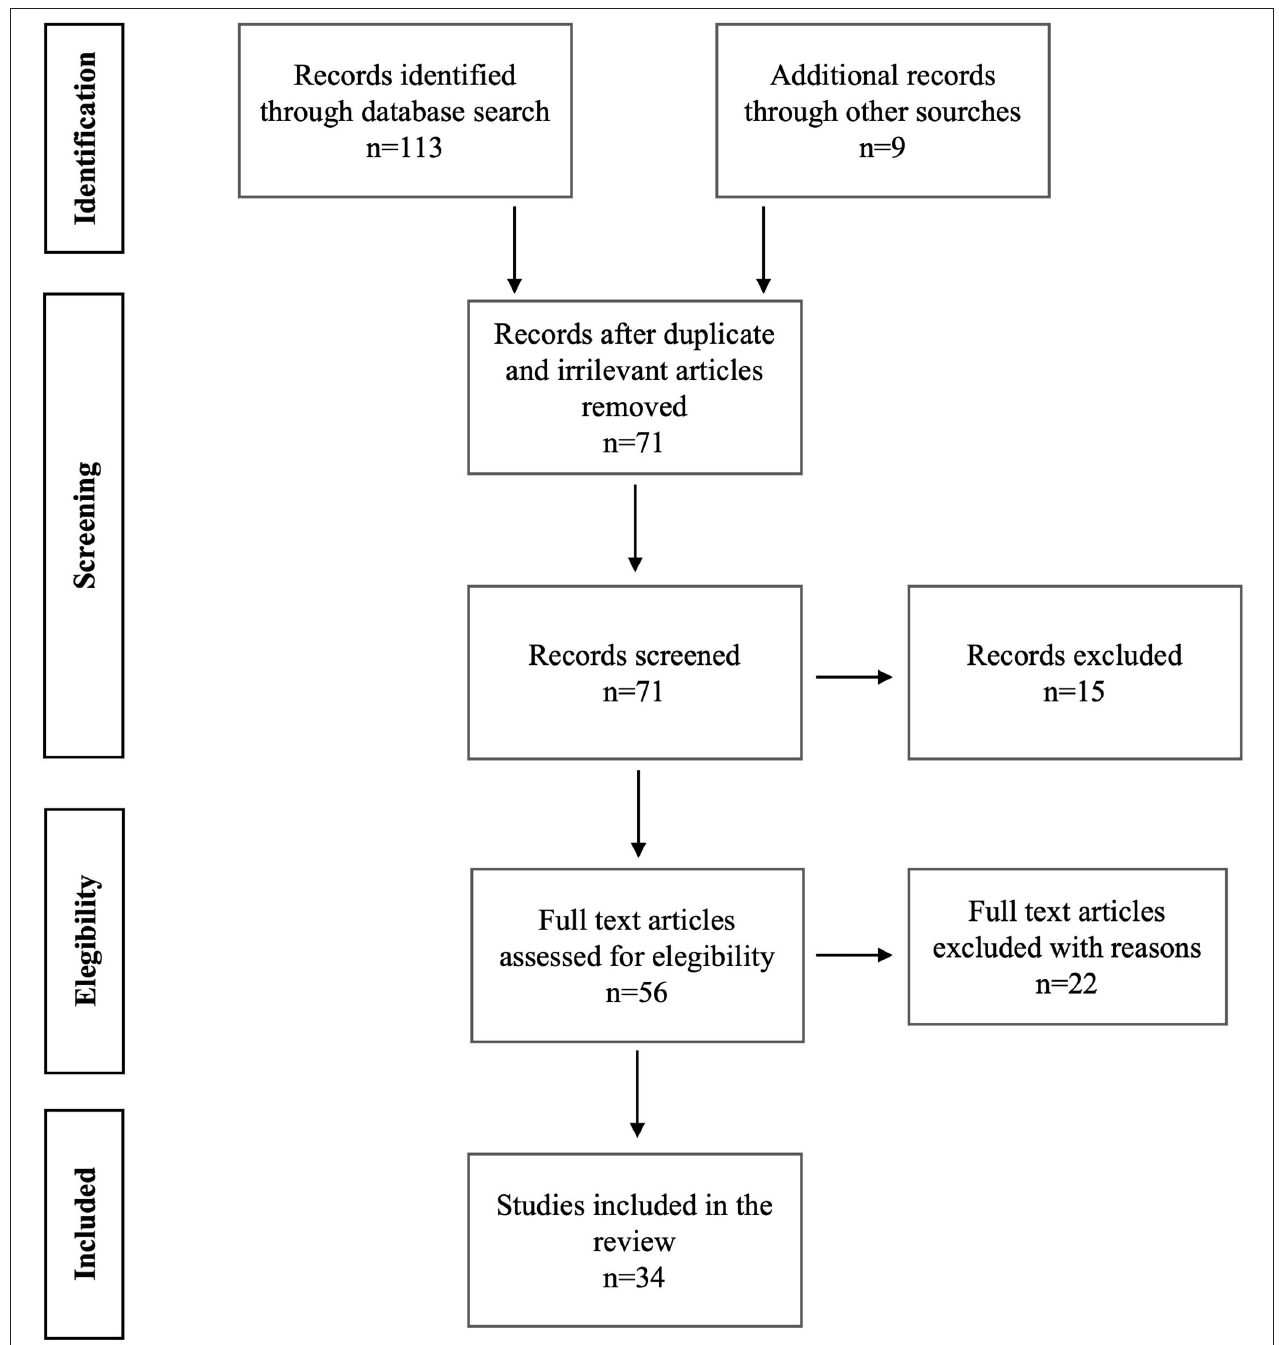
of biological, and different from sexology and sexual medicine. Figure 1 represents the flowchart showing further details on the literature search and the selection of articles included in this literature